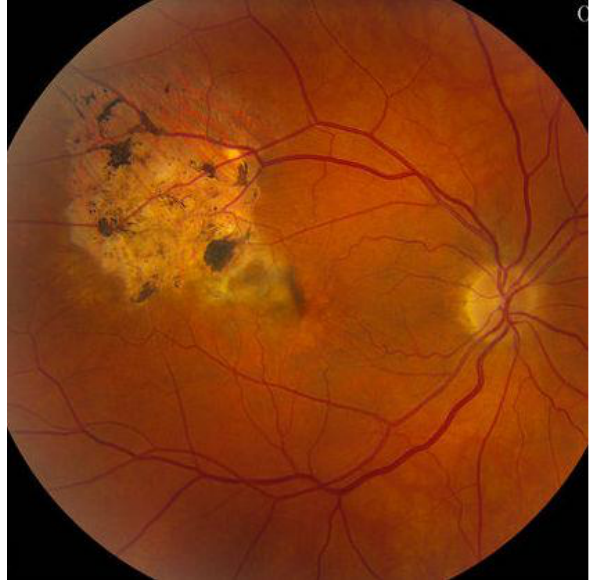
Figure 10. Choroidal osteoma.